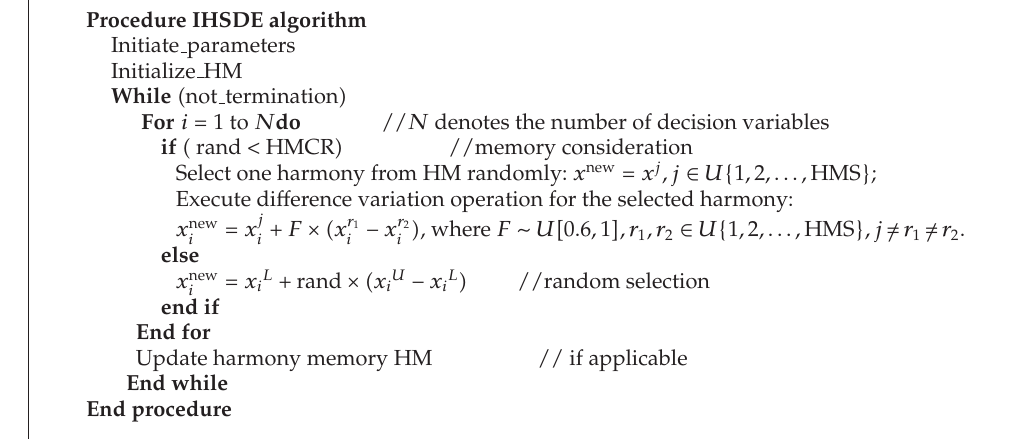
Algorithm 1: Pseudocode of the IHSDE